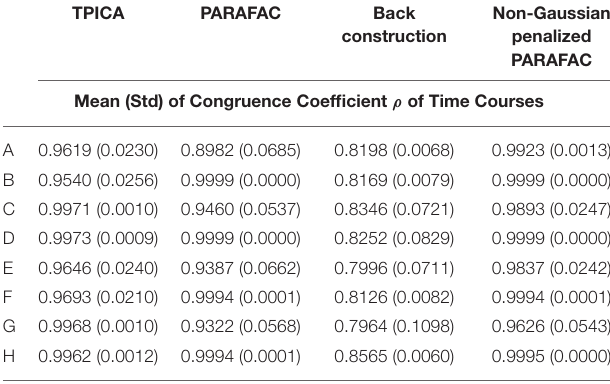
TABLE 3 | Experimental Results of the mean and std of ρ of time courses in all four algorithms. TPICA PARAFAC Back